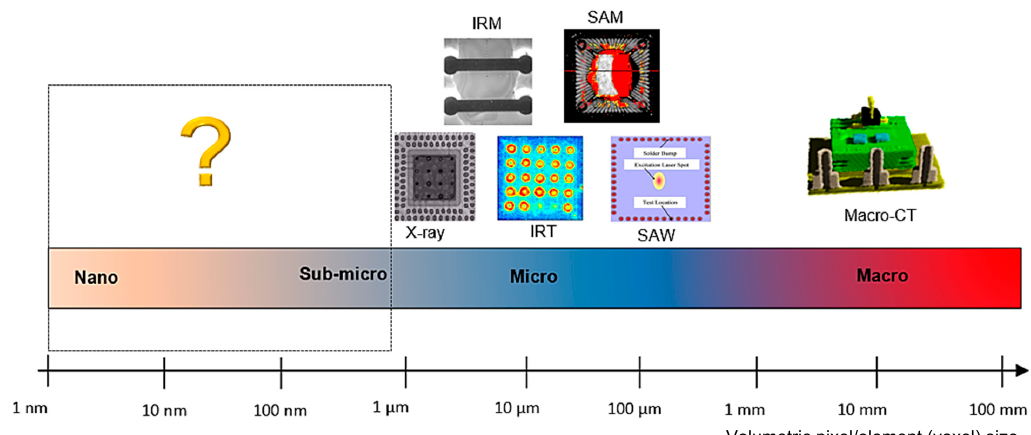
Figure 3. Schematic demonstration of the technology gap between the IC package size and the spatial resolution of NDT methods.